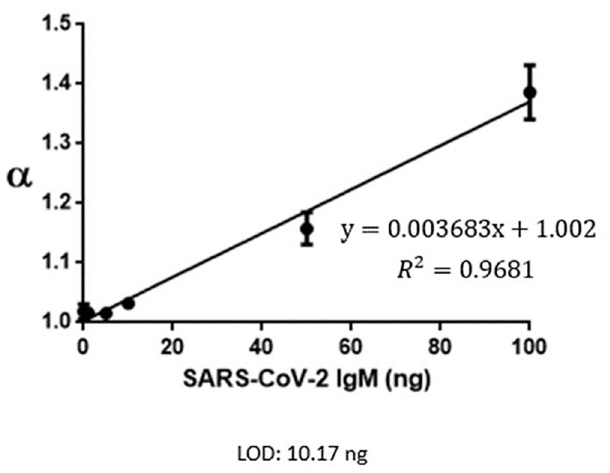
Fig 2. SARS-CoV-2 IgM standard